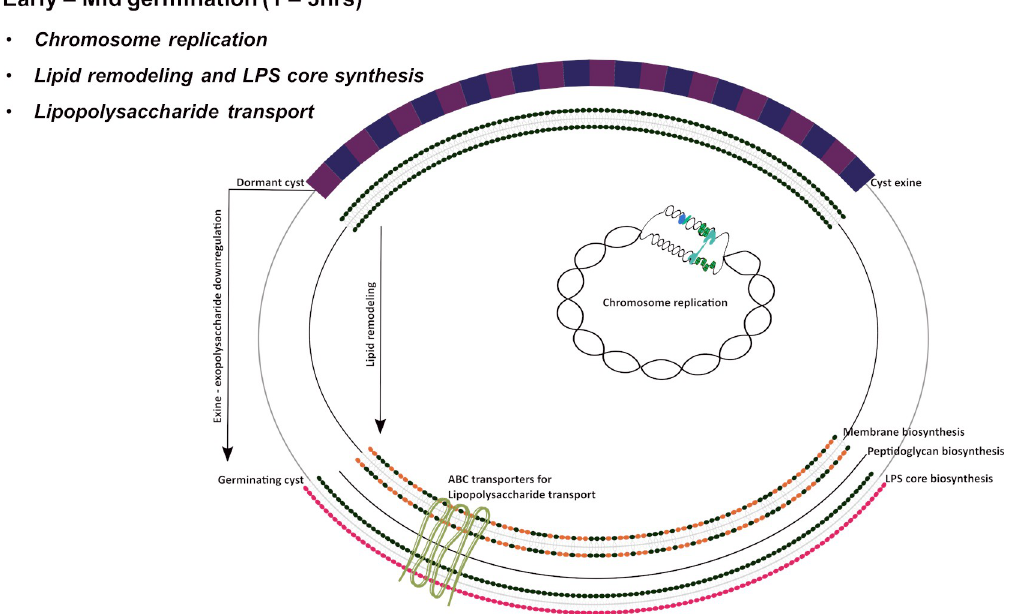
Fig 4. Diagram of cellular processes that undergo changes during the early to middle germination period (1 to 3 hrs.).